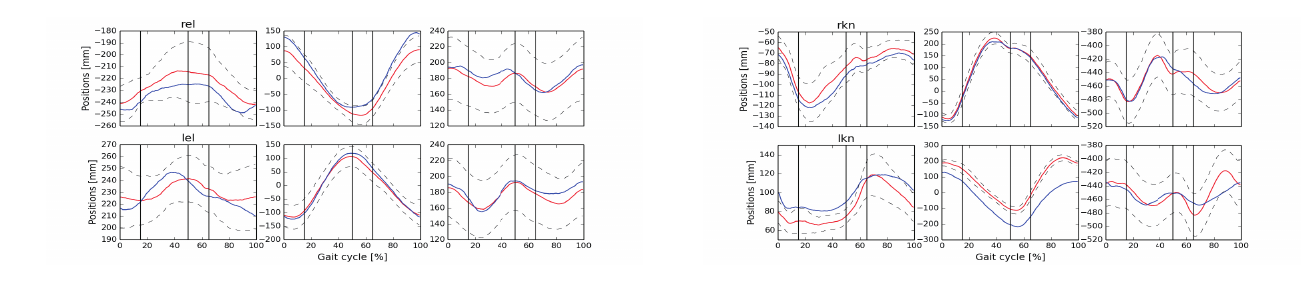
Figure 9: Comparison of elbow positions